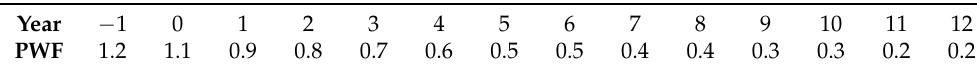
Table 4. Present worth factor applied (value of USD 1 at year y). Year 0 corresponds to the start of the operation.